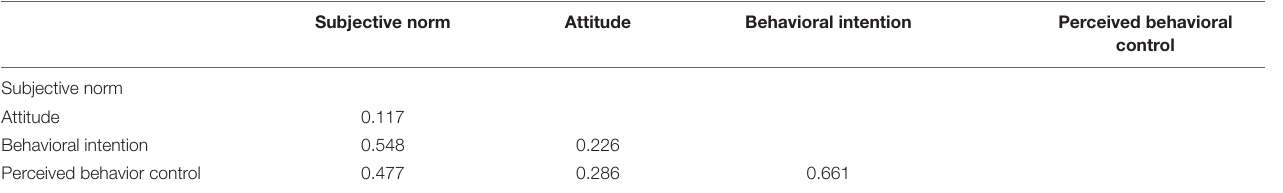
TABLE 3 | Analysis of discriminant validity (heterotrait–monotrait ratio).